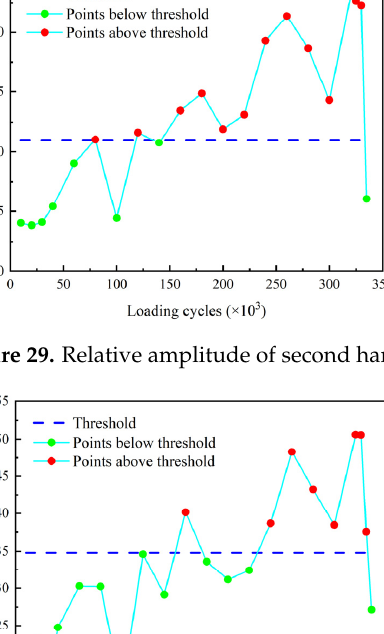
Figure 30. Relative acoustic nonlinear parameter 𝛽 (cid:4593) versus loading cycles